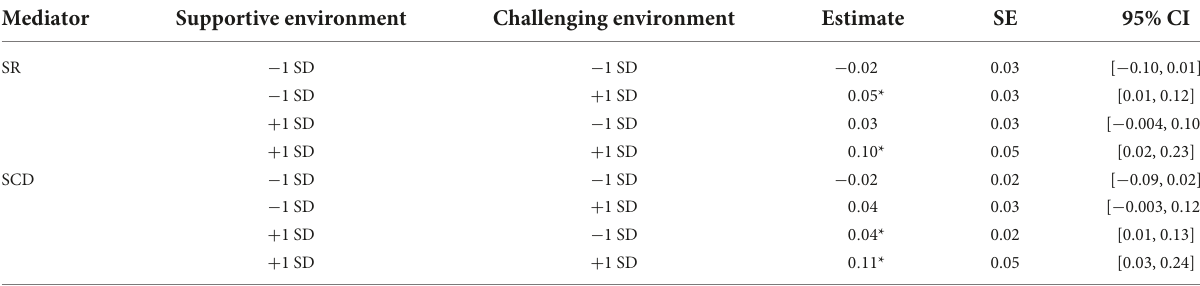
TABLE 6 Conditional indirect effects of JSC on reemployment quality at different values of reemployment context. Mediator Supportive